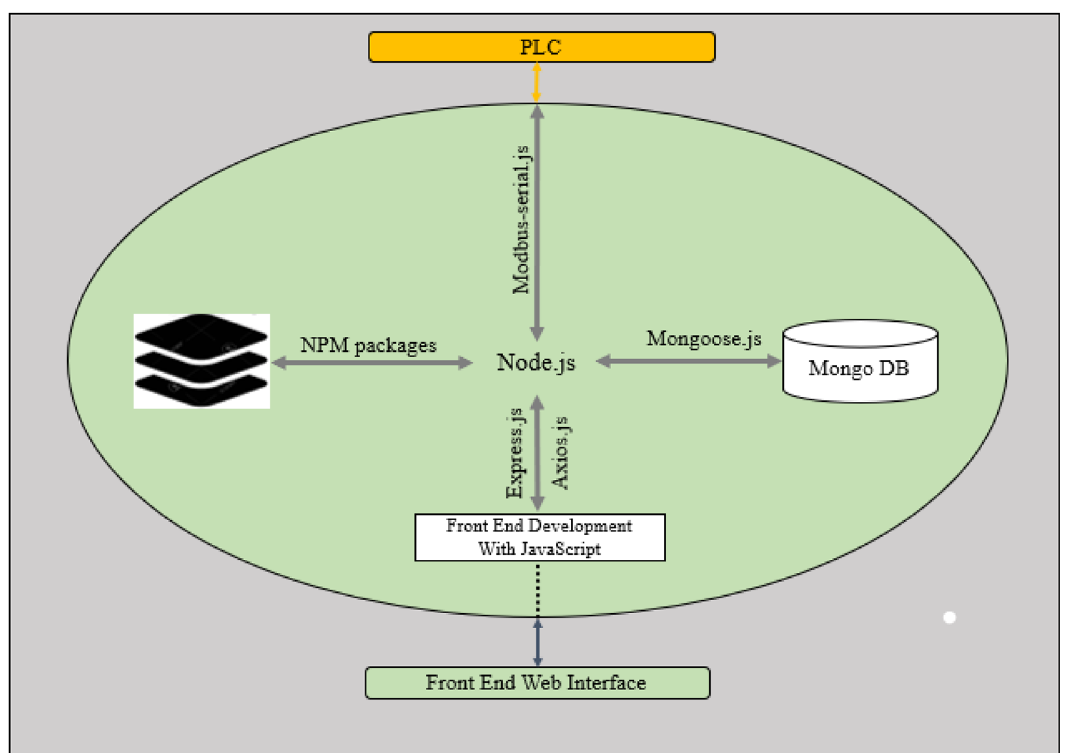
Figure 12. Node.js Program Structure on Raspberry